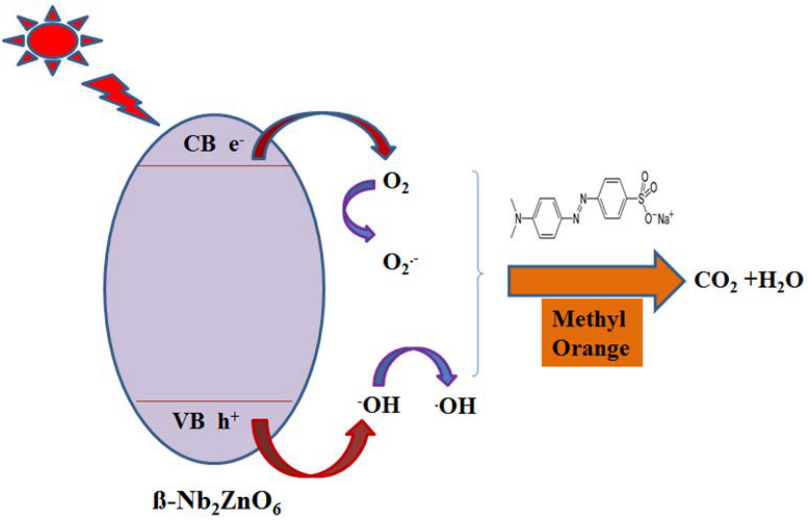
Figure 6. Schematic illustration of photocatalytic activity of β -Nb 2 ZnO 6 for the degradation of methyl orange.